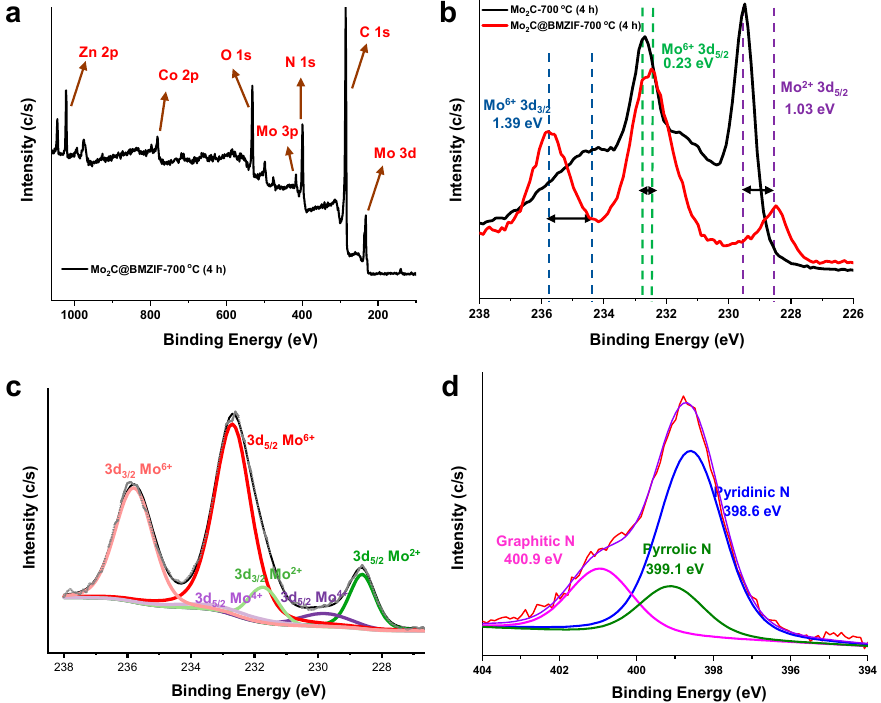
Figure 4. ( a ) XPS profiles of Mo 2 C@BMZIF-700 °C (4 h). ( b ) XPS Mo 3d spectra compared to a pure Mo 2 C-700 °C (4 h) nanorod and the Mo 2 C@BMZIF-700 °C (4 h) core@shell structure. XPS ( c ) Mo 3d and ( d ) N 1s spectra of Mo 2 C@BMZIF-700 °C (4 h).